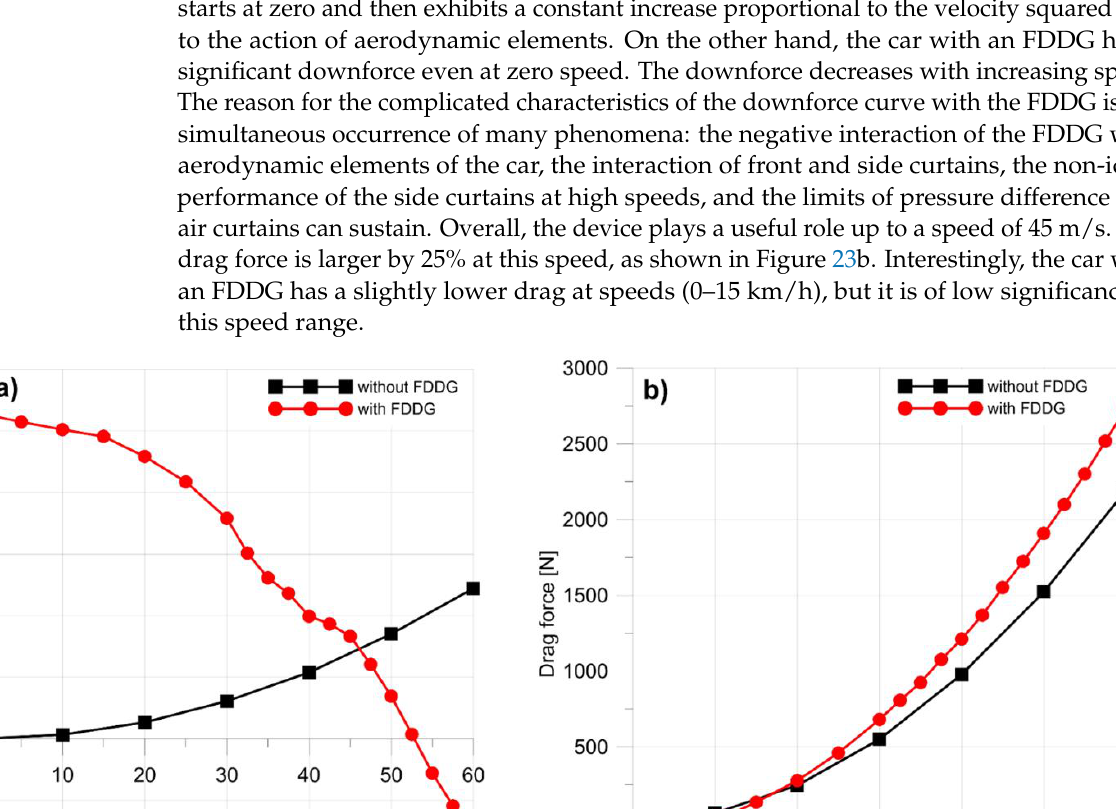
Table 1. Grid convergence test results.